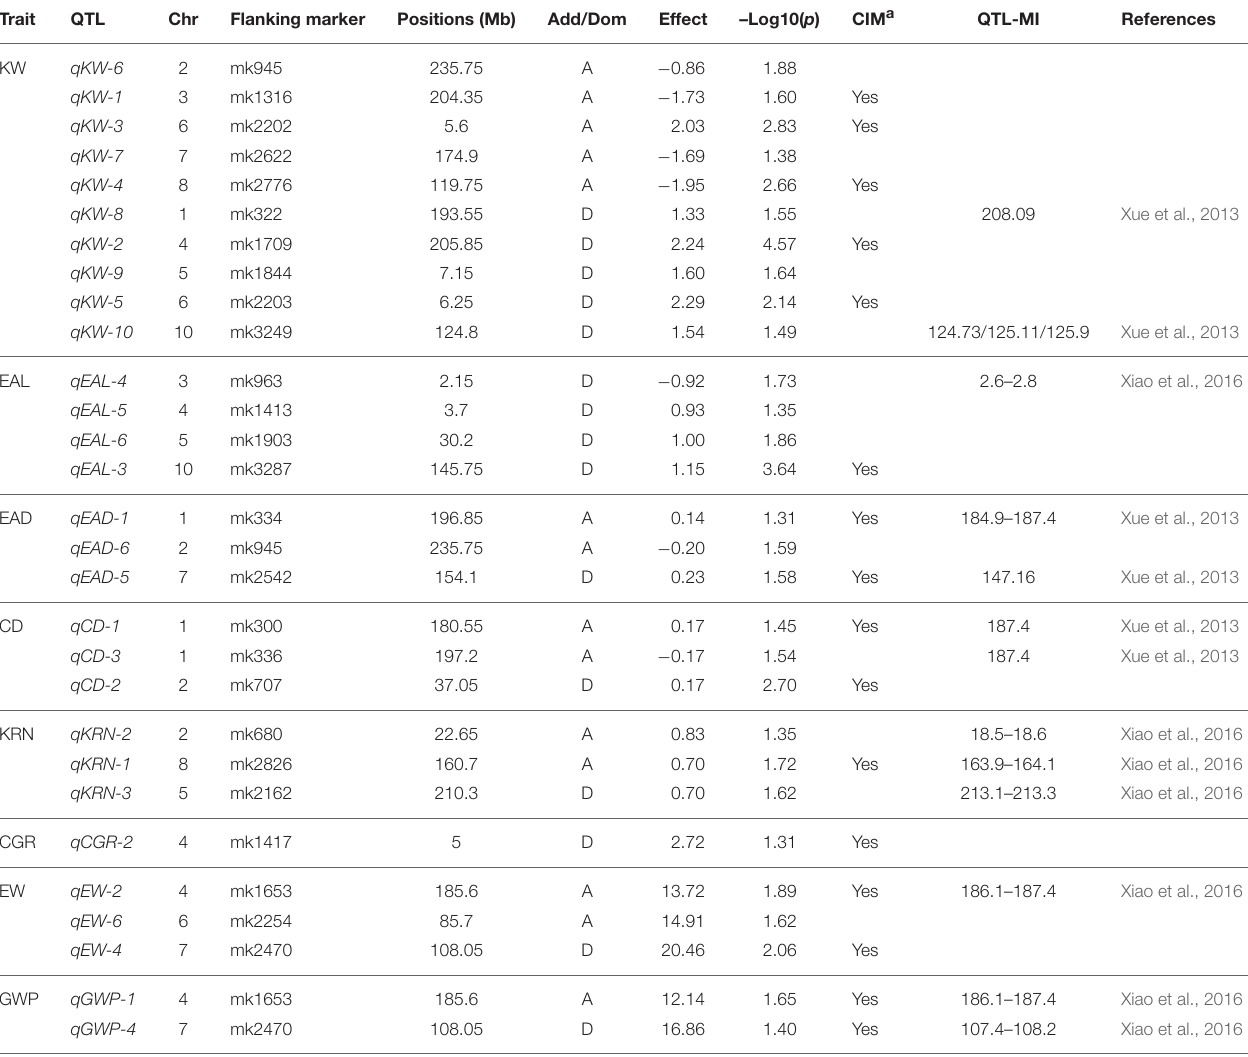
TABLE 5 | QTL identified for nine traits of maize using high-density SNP bin-map from the LASSO method. Trait QTL Chr Flanking marker Positions (Mb) Add/Dom Effect –Log10( p ) CIM a